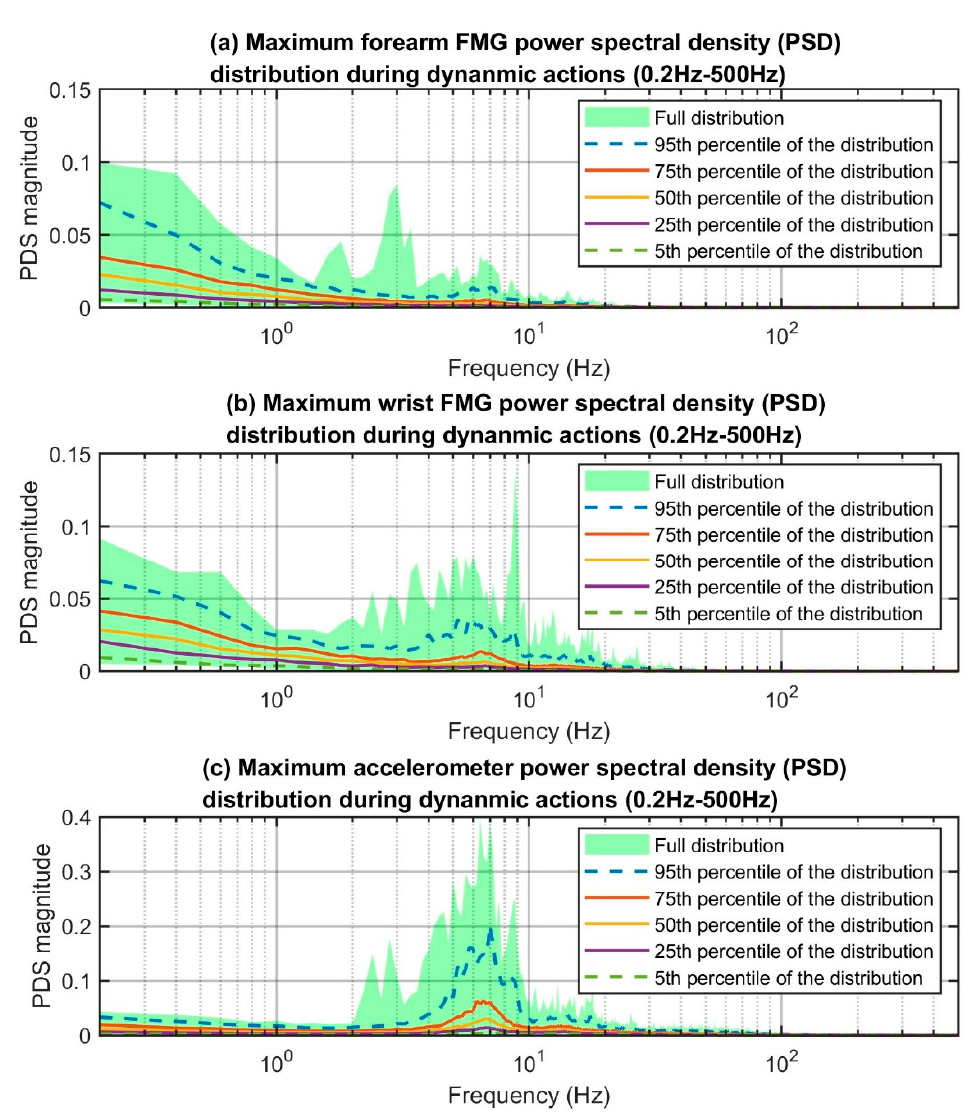
Figure 9. Maximum FMG power spectral density (PSD) distribution of FMG and the accelerometer signal during dynamic actions.